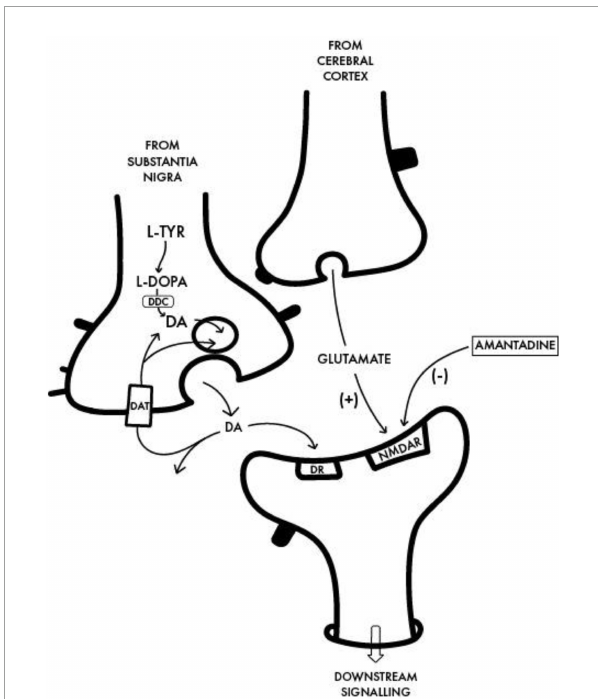
FIGURE2 Interface between a dopaminergic nigrostriatal nerve terminal in which DA is synthesized from L-Tyrosine [L-TYR] via L-DOPA to dopamine with a glutamatergic terminal of the cortico-striatal tract and the postsynaptic neuron. The benefit of amantadine for the treatment of the motor disturbances in PD is attributed to its non-competitive antagonist action on the post-synaptic NMDA receptor [NMDAR] resulting in the restoration of the balance between nigrostriatal and corticostriatal inputs in favor of increased net production of DA. DDC, Dopa decarboxylase; DAT, dopamine transporter; DR, post-synaptic DA